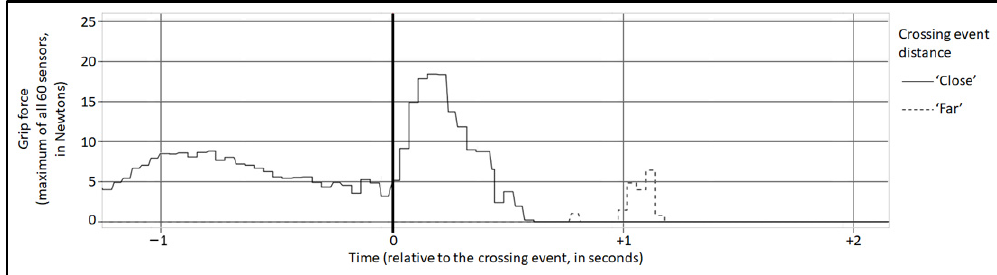
Figure 7. Raw grip force data from two crossing events of a single participant (randomly selected). X -axis represents time in relation to the crossing event (minus = before the event). Y -axis represents the maximal grip force at each measurement instance for all 60 sensors. The continuous line represents a ‘Close’ crossing event, while the dashed line represents a ‘Far’ crossing event.